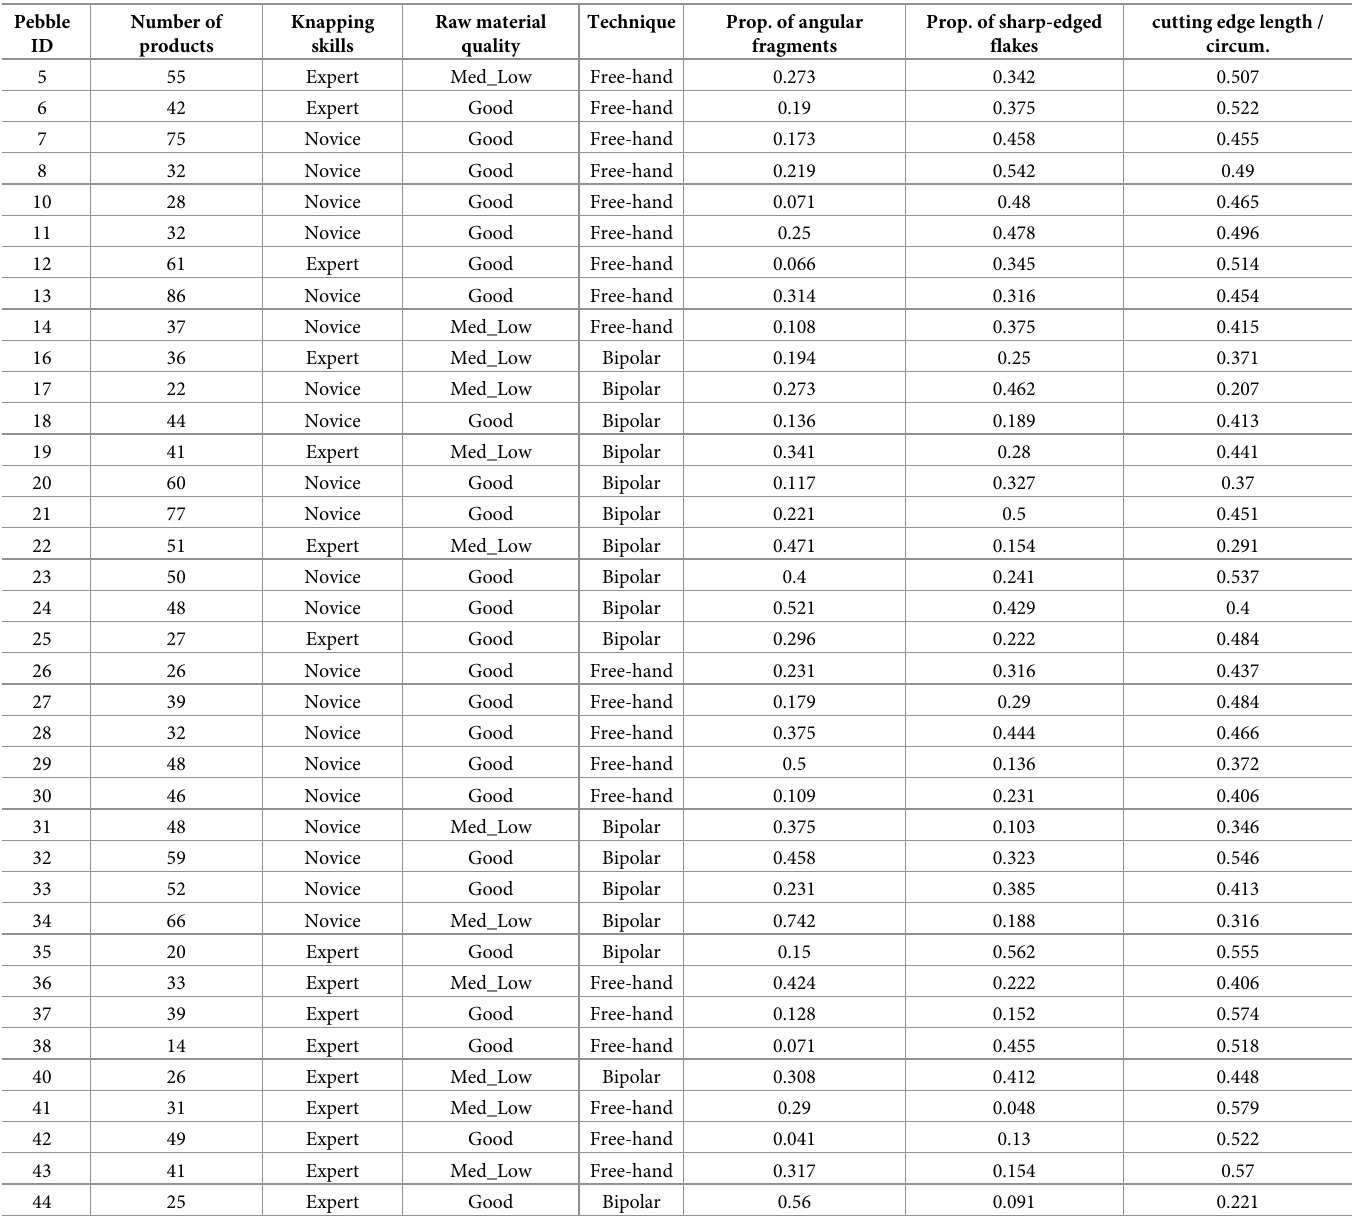
Table 2. Experimental data: Computation of useful variables for each